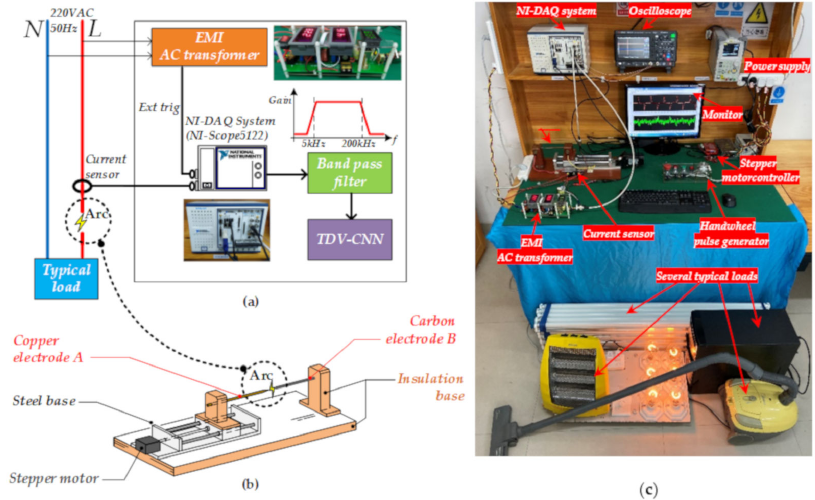
Figure 8. ( a ) Schematic of the experimental platform; ( b ) arc fault simulator; ( c ) actual experimental